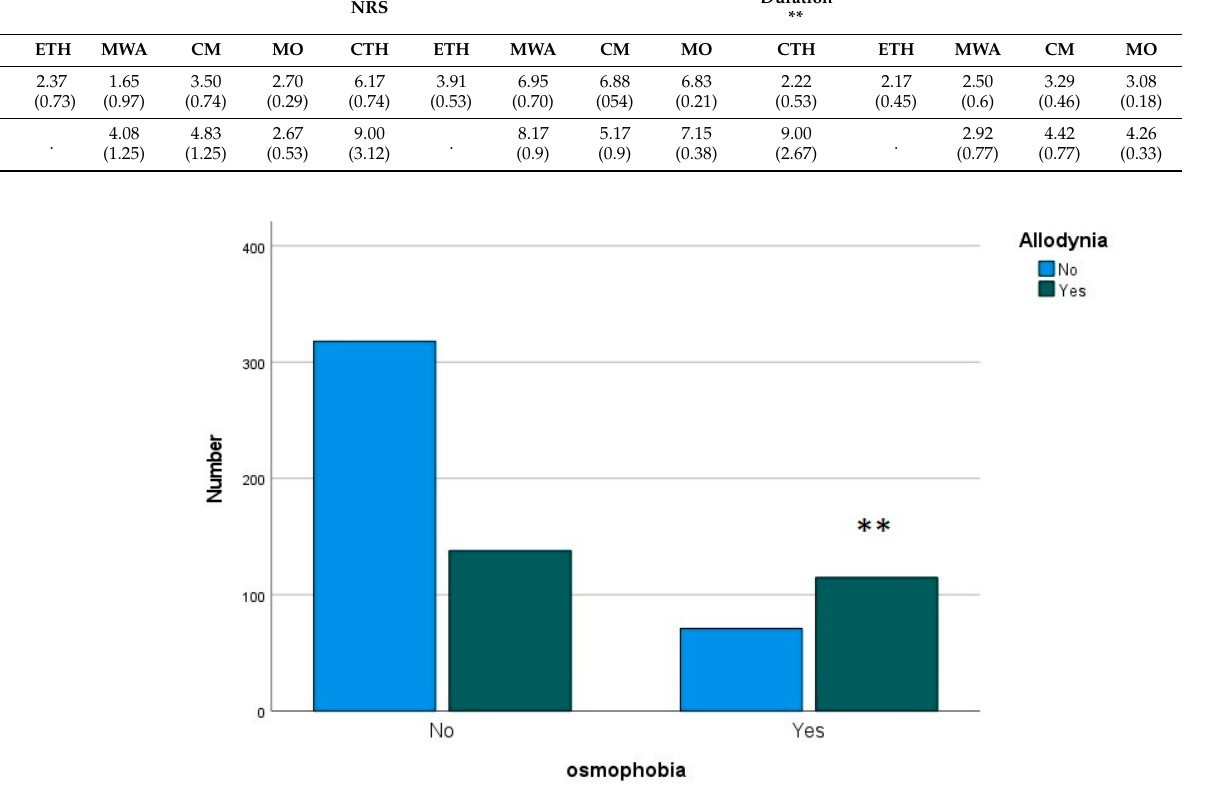
Figure 2. Number of primary headache patients presented with symptoms of acute allodynia in the groups without and with osmophobia. In the latter group, patients with allodynia dominated. ** chi-squared 55.12; p < 0.001.